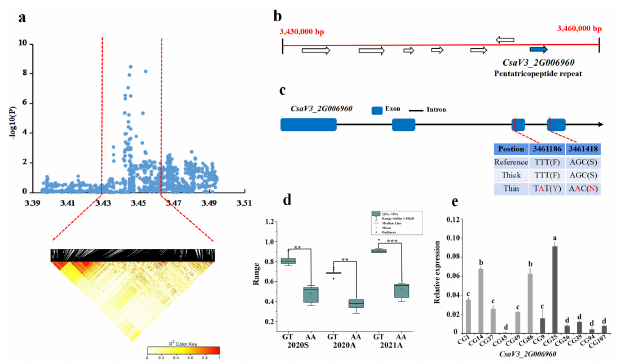
Figure 5. Identification of the stem diameter-related gene at locus gSD2.1 . ( a ) Manhattan map of near 100 kb ( top ) and LD heatmap ( bottom ) surrounding the peak of gSD2.1 . ( b ) Seven genes predicted in the LD block region. Blue represents the genes that are different. ( c ) SNP variation of the candidate gene CsaV3_2G006960 among thick and thin stem lines (Table S6). Two SNPs (in red) were located in CDS, resulting in amino acid changes. ( d ) Haplotype difference of CsaV3_2G006960 . *** indicatess significance p < 0.001. ** indicatess significance p < 0.01. * indicatess significance p < 0.05. ( e ) Relative expression analysis of CsaV3_2G006960 . Gray column represents the thin stem samples (CG1, CG14, CG37, CG45, CG49, CG86); Black column represents thick stem samples (CG9, CG25, CG26, CG39, CG94, CG107). a,b,c and d represent the level of significant difference from high to